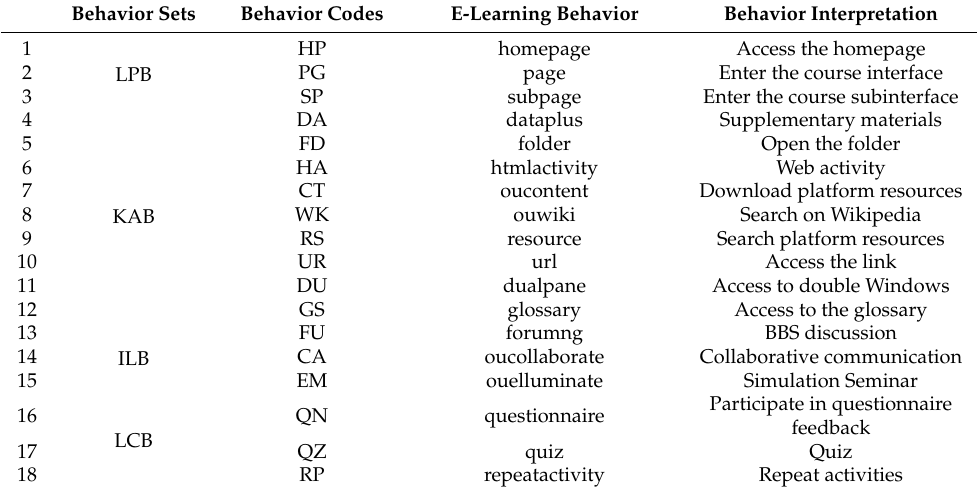
Table 1. E-learning behavior and coding of FFF